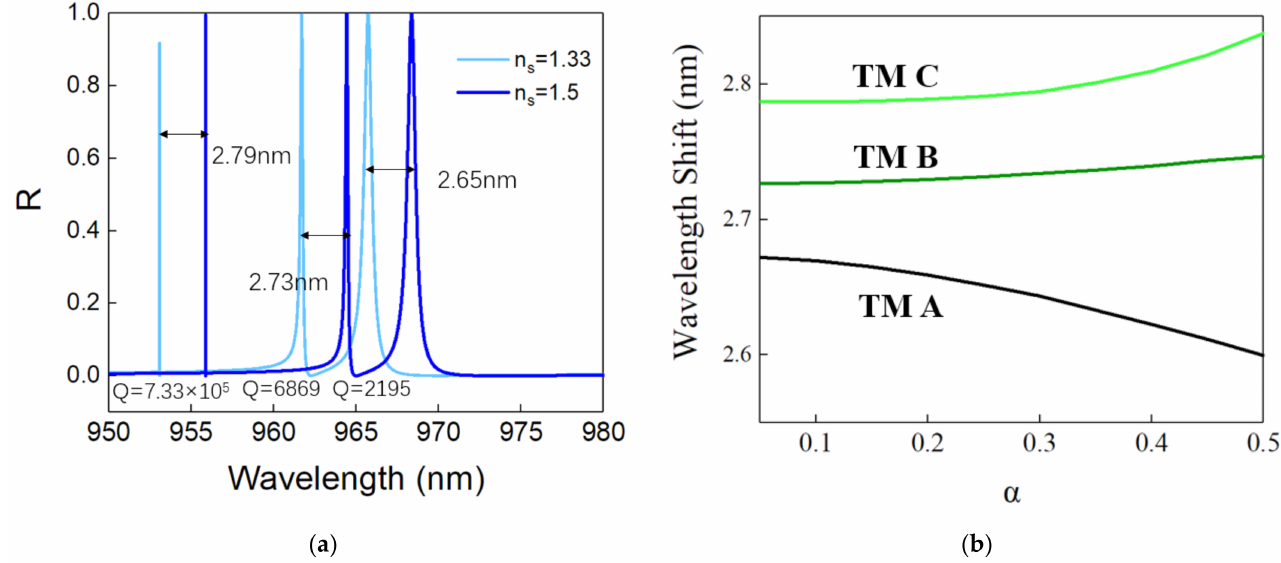
Figure 9. ( a ) The shifts in the peak positions and the Q factor when the surface refractive index changed from 1.33 to 1.5. ( b ) The wavelength shifts of the silicon nitride sensor variation with the asymmetry parameter α